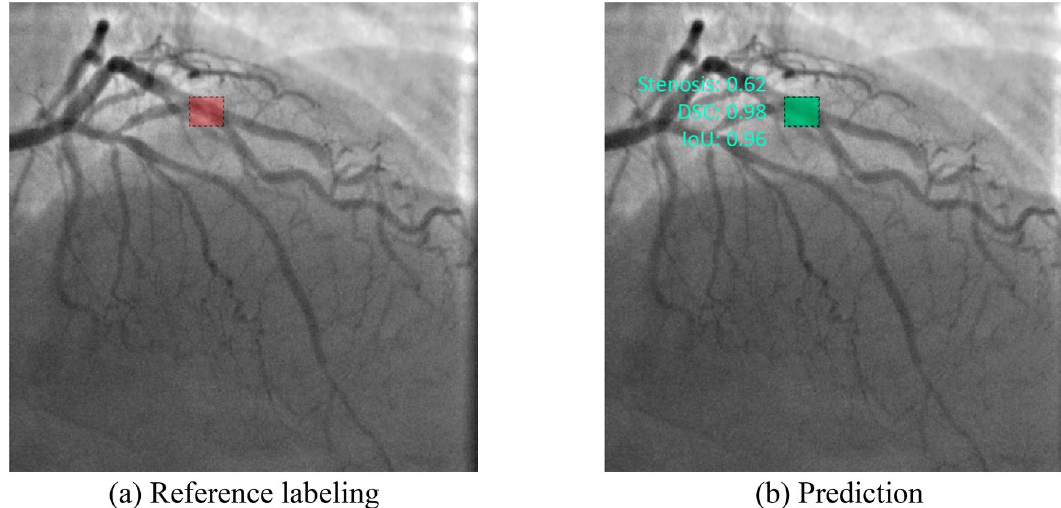
Figure 10. Example of the best prediction compared to reference labeling: data of patient 2 processed with SSD MobileNet V2